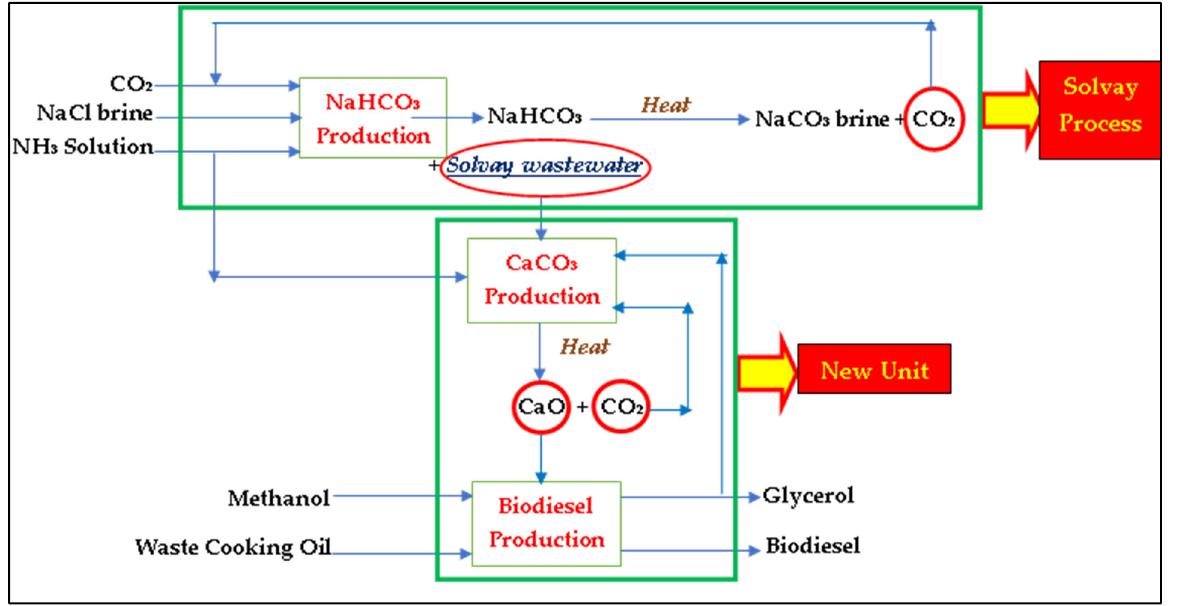
Figure 21. Optimum biodiesel production process utilizing Solvay wastewater, CO 2 , and waste cooking oil.